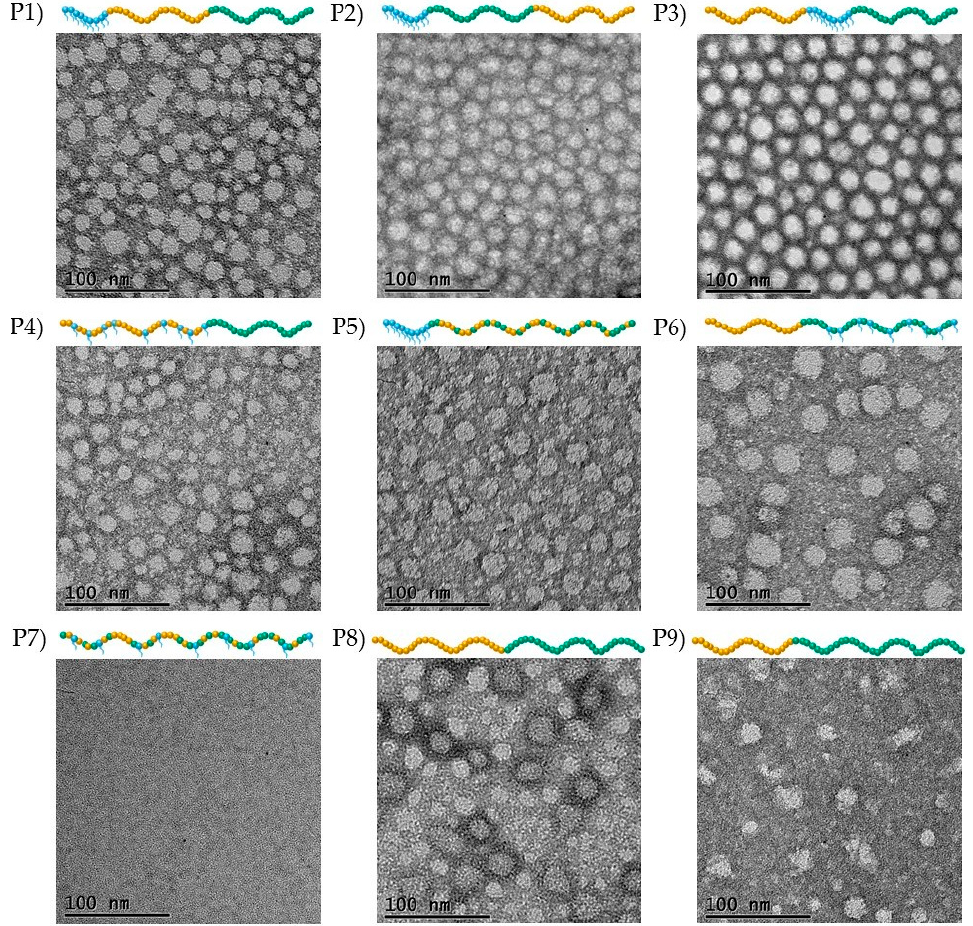
Figure 5. Transmission electron microscopy (TEM) images of 1% w / w negatively-stained copolymer solutions at pH 6. The scale bar is set at 100 nm. The schematics of the polymer structures are also given; Blue, orange, and green spheres represent the TEGMA, BuMA, and DMAEMA units, respectively.